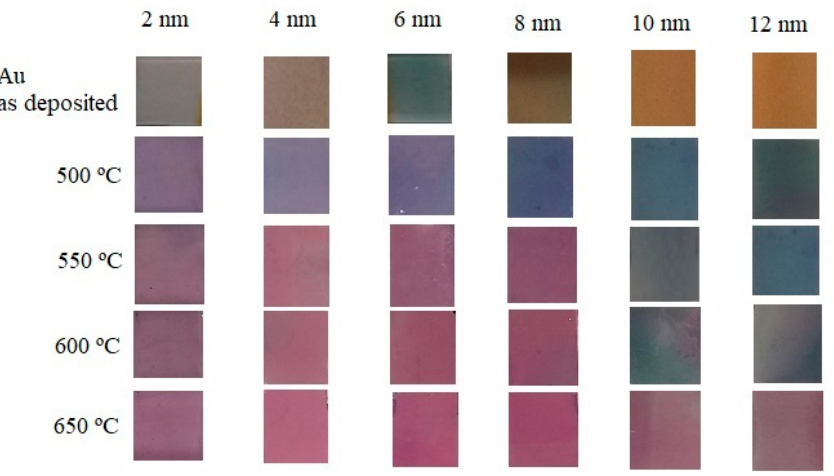
Figure 5. Gold coated planar samples photographed before and after annealing at 500, 550, 600 and 650 °C for 1 h with initial thicknesses of 2, 4, 6, 8, 10 and 12 nm.